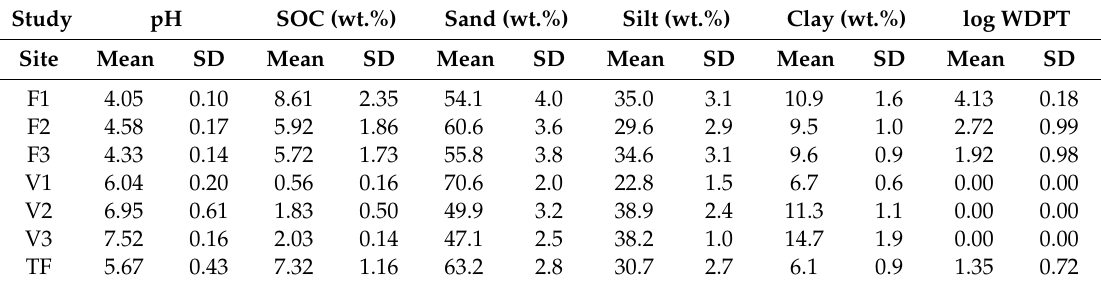
Table 2. Basic soil properties determined in 10 samples at each study